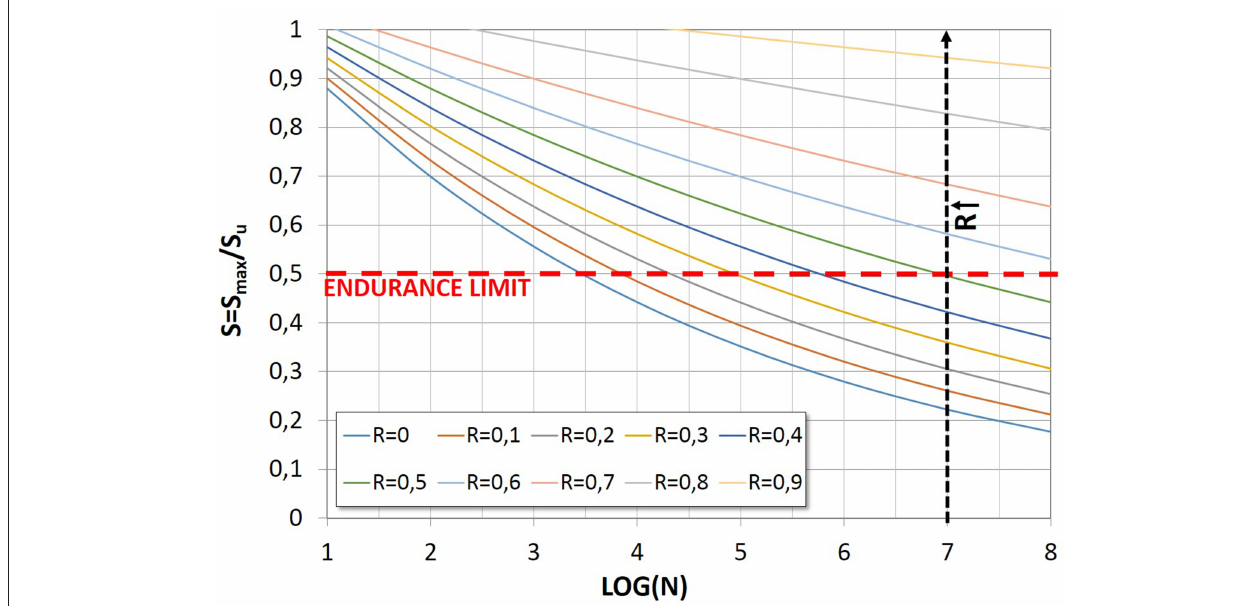
FIGURE 2 | Casas (2009) fatigue curves, referred to a 5% of failure probability.